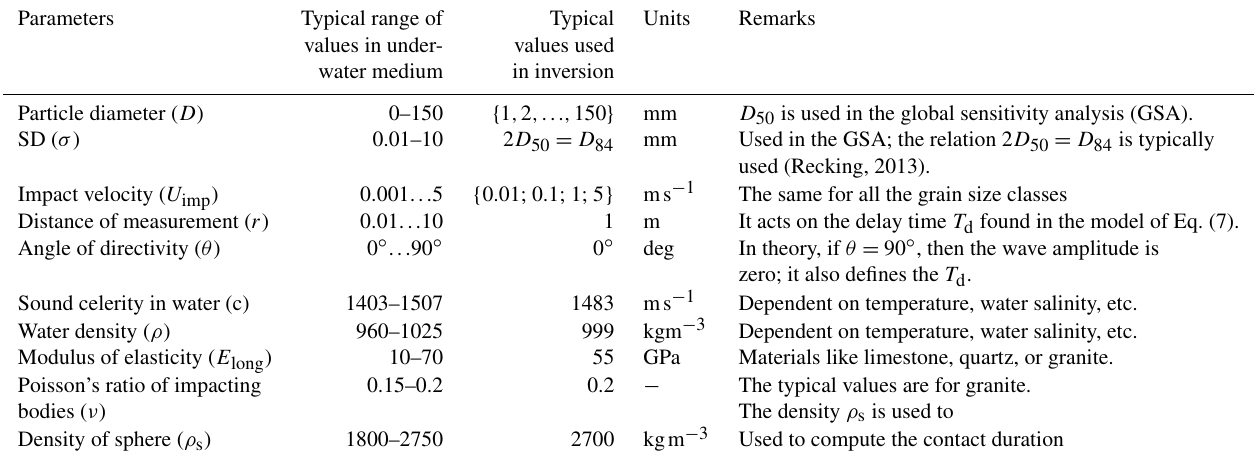
Figure 1. (a) Setup for the impact between two spheres, here of the same radius a ; the acoustic dipole source is illustratively depicted by the gray patch; (b) setup for the impact between a sphere of radius a and a semi-infinite rigid plane; to be noted is the boundary condition of the hard bottom (reflector) assumed in the framework of the “method of images”; thus, the impacting sphere is mirrored in the slab, so the acoustic fields are subtracted; the acoustic dipole source is illustratively depicted by the gray patch; (c) the elementary acoustic process of bedload noise in the river: the particle of equivalent diameter D = 2 a impacts the armored river bed (a massive slab) which generates a transient recorded by a hydrophone. Table 1. Parameters used to model analytical spectra of sediment size mixtures, Eq. (9b), and the typical values adapted for the underwater environment. The typical singular values are used in inversion further in this paper. The ranges of values are used in the global sensitivity analysis. K is the number of size classes used to inverse acoustic